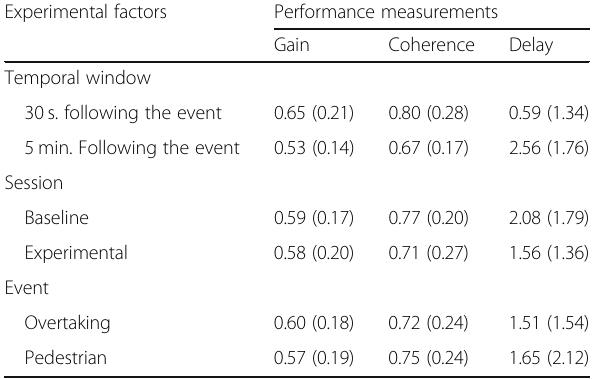
Table 2 Mean values of MSCL, HR and HRV as a function of temporal window, session and event (SD in brackets) Experimental